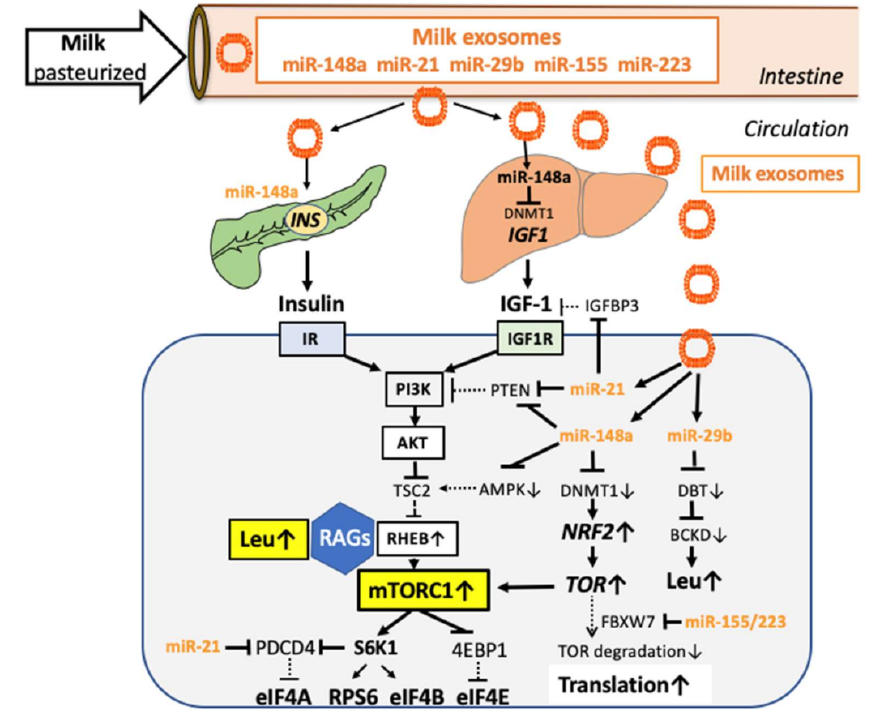
Figure 2. Model of milk miR-mediated epigenetic regulation increasing mTORC1 signaling. Milk- derived exosomal miRs enhance insulin/IGF-1/PI3K/AKT signaling, enhance intracellular levels of BCAAs, and promote mTOR expression. Abbreviations: miR: micro-ribonucleic acid; DNMT1: DNA methyltransferase 1; INS : insulin gene; IR: insulin receptor; IGF1 : IGF-1 gene; IGF-1: insulin-like